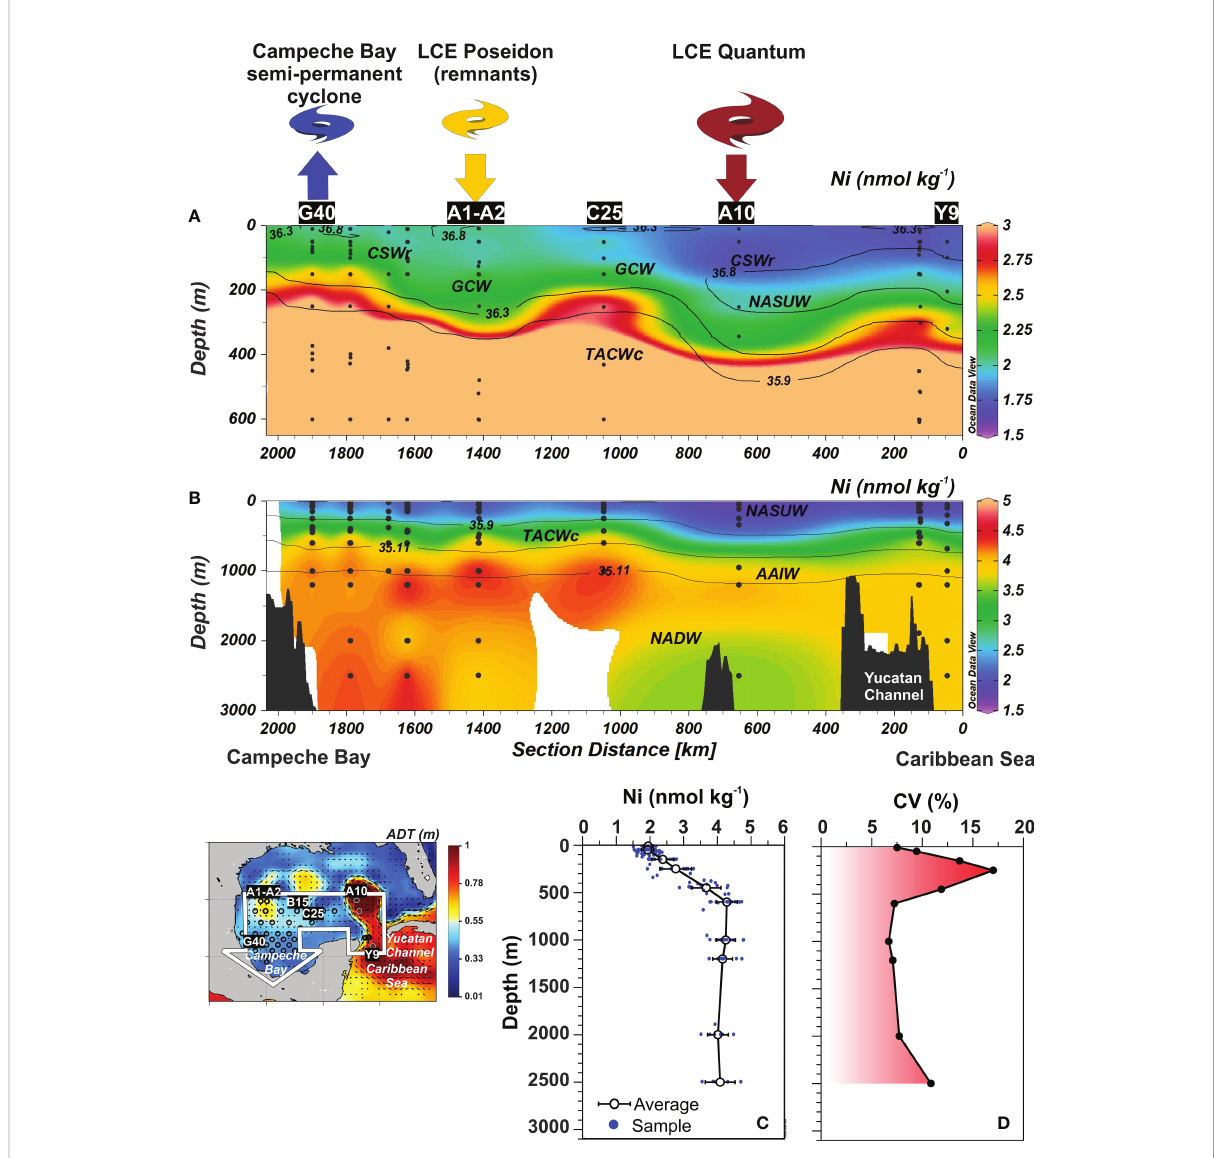
FIGURE 4 Sectional distribution of dissolved Ni along a transect that begins in the Caribbean Sea and ends in the Gulf of Mexico in the Campeche Bay area during the XIXIMI-6 cruise: (A) from 0 to 600 m depth and (B) from 0 to 3500 m depth. (C) Average vertical pro fi le (± standard error) and (D) coef fi cient of variation (CV) of dissolved Ni for depths 10, 50, 150, 250, 450, 500, 1000, 1200, 2000, and 2500 m. The average pro fi le was constructed using the dissolved Ni concentrations measured in the 22 stations sampled during the XIXIXMI-6 cruise. The locations of the sampling stations marked in (A) are shown on the map. The big white arrow shown on the map indicates the direction and extent of the transect. To highlight the spatial differences in the Ni concentration in both shallow and deep waters, the range of Ni concentrations represented by the color scale is different for (A, B) . The black solid contours in (A, B) indicate the isohaline boundaries of water masses based on the classi fi cation proposed by Portela et al. (2018). LCE, Loop Current eddy; ADT, absolute dynamic topography; CV, coef fi cient of variation; CSWr, Caribbean Surface Water remnant; GCW, Gulf Common Water; NASUW, North Atlantic Subtropical Underwater; TACWc, Tropical Atlantic Central Water core; AAIW, Antarctic Intermediate Water; and NADW, North Atlantic Deep